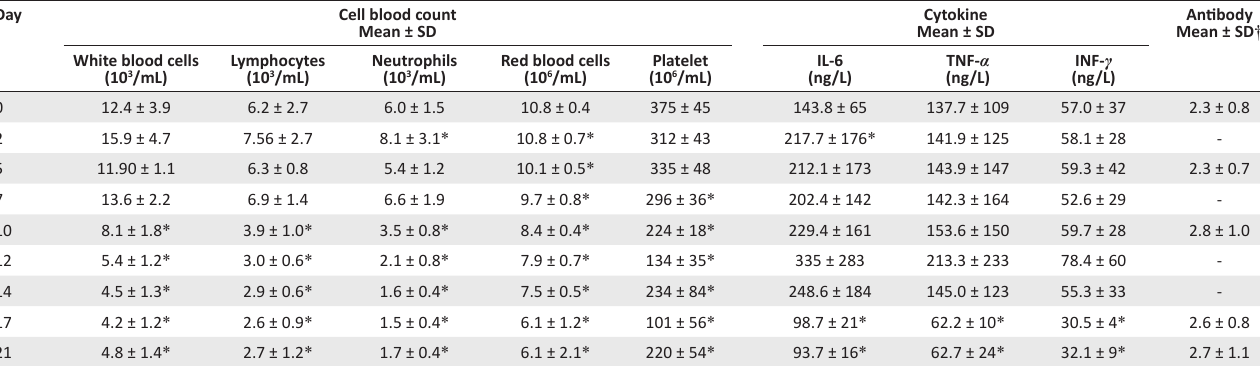
Cytokine Antibody Mean ± SD Mean ± SD †